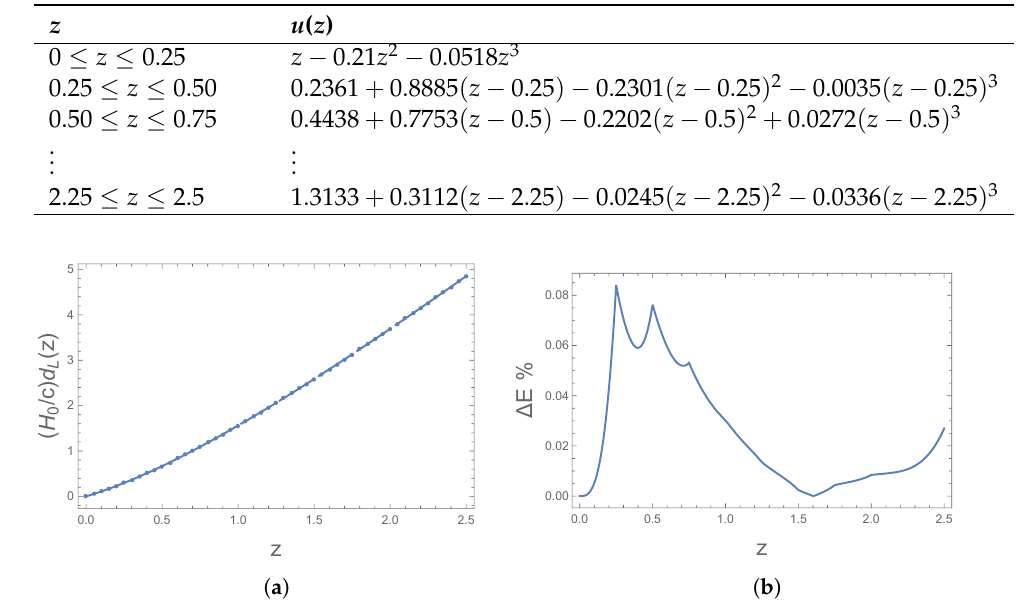
Table 1. Piecewise convergent approximate solution for u ( z ) with Ω m = 0.28.